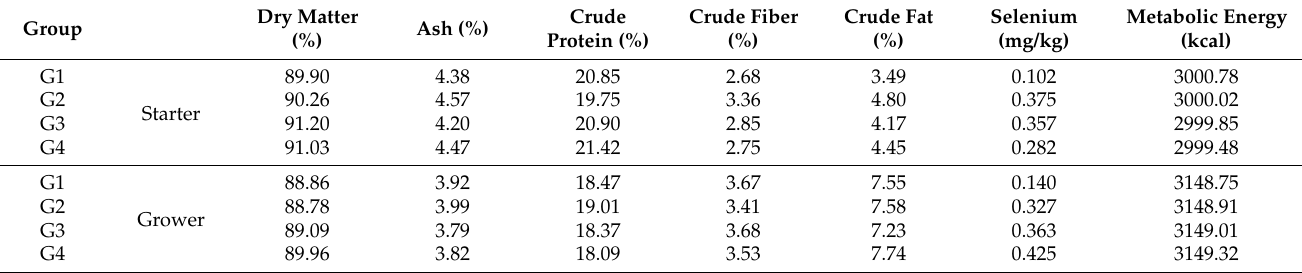
Table 2. Marked composition of